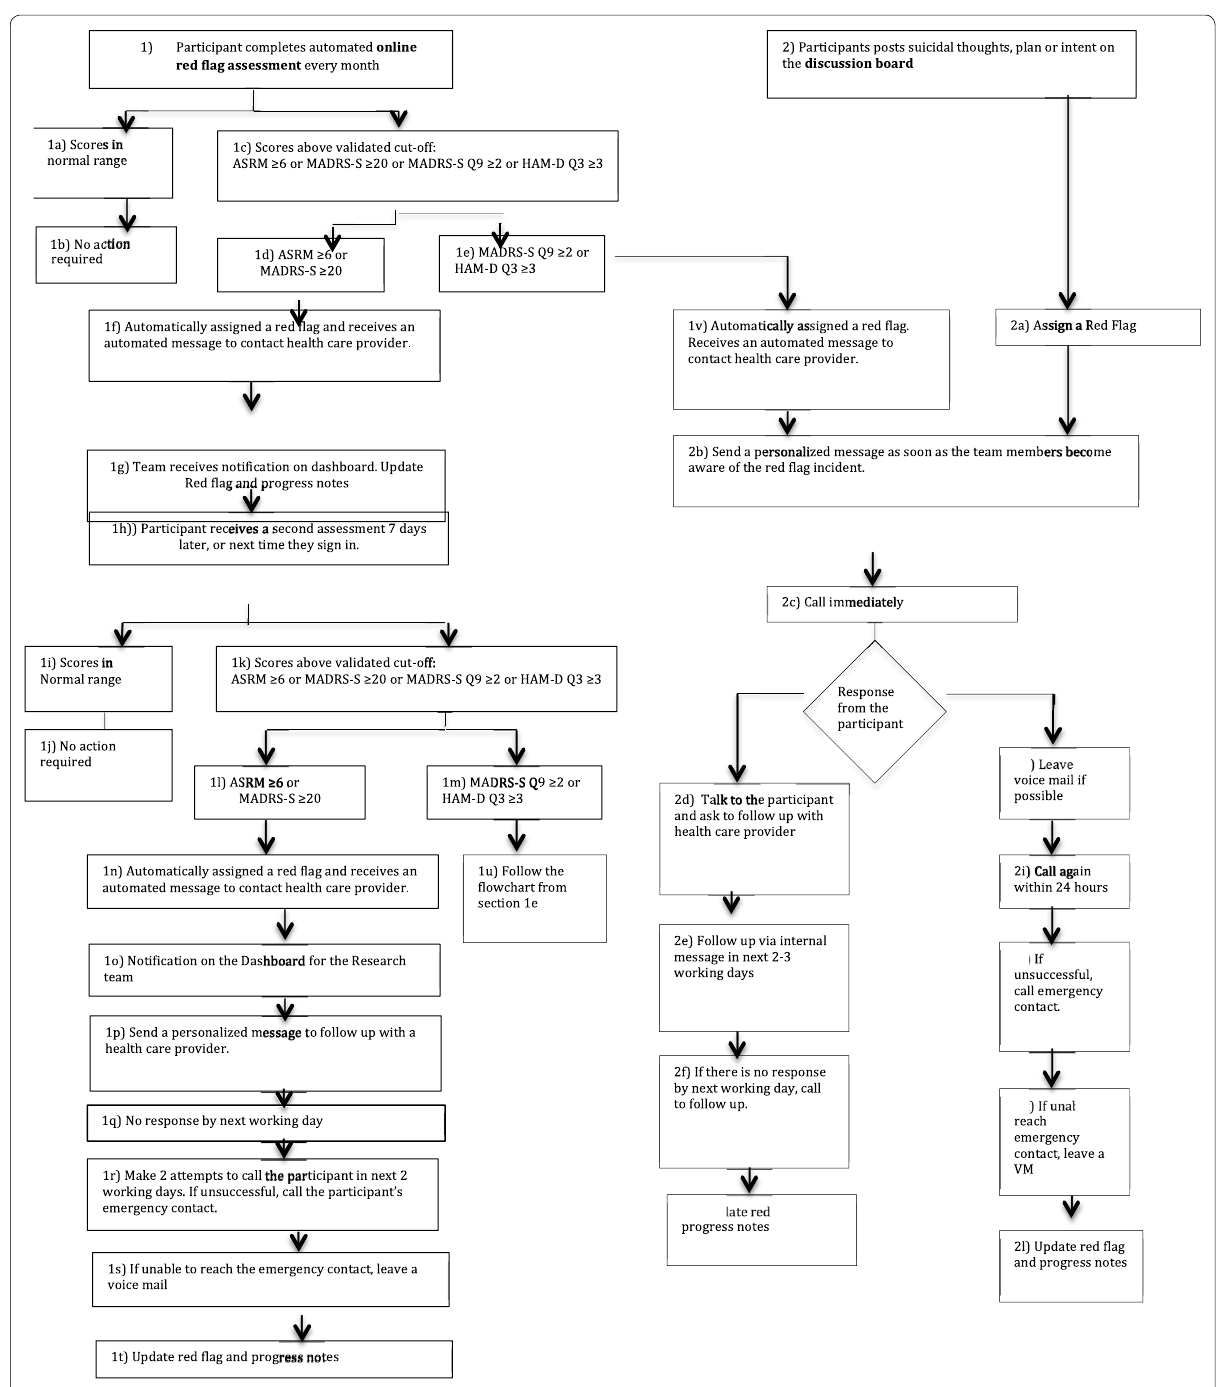
Fig. 2 MoodSwings 2.0 Red Flag Monitoring System flowchart: self-assessment and discussion board components. Figure includes detailed model for Red Flag Monitoring System designed to identify via routine self-report methods study participants at high risk for suicidal behavior and provide guidance for services and care. Participants are also identified as high risk if the content of their discussion board posts is deemed concerning by study